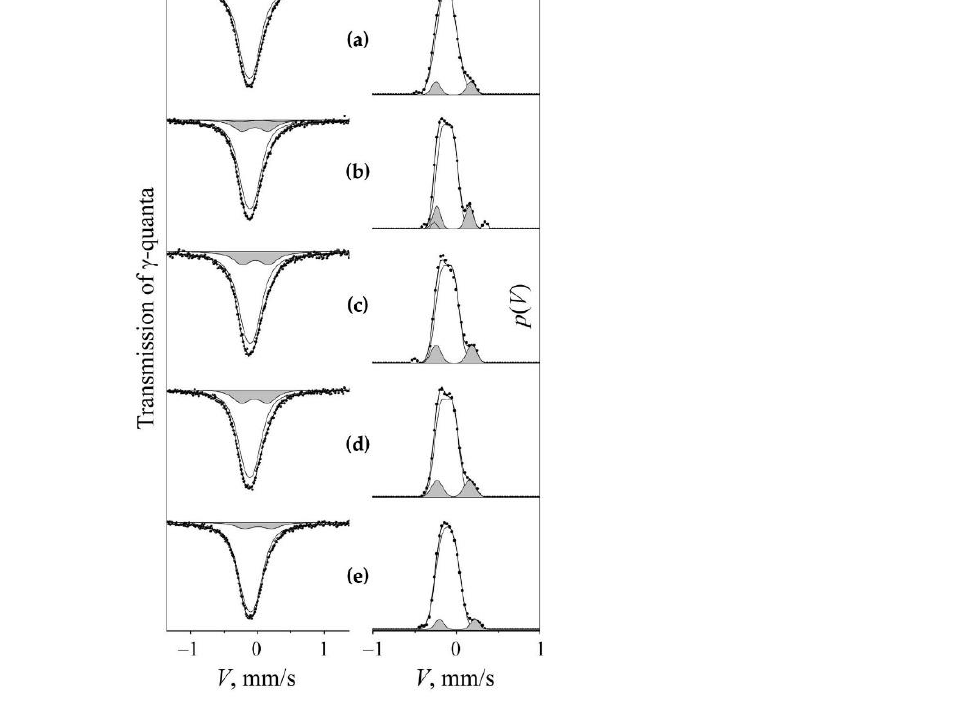
Figure 7. Mössbauer spectra and distributions of p ( V ) of FeMn 22 Cr 18 N 0.83 pre-aged steel at 1073 K, 2 h with a change in the degree of deformation n (number of revolutions n ) by HPT at 298 K. ( a ) — aging; ( b ) — n = 0.5 rev.; ( c ) — n = 1 rev.; ( d ) — n = 5 rev. ( e ) — spectrum and distribution of p ( V ) in the aged steel after HPT of n = 3 rev. at 573 K. The component of the “ nitrogenous ” doublet S D 1 is highlighted by darkening.